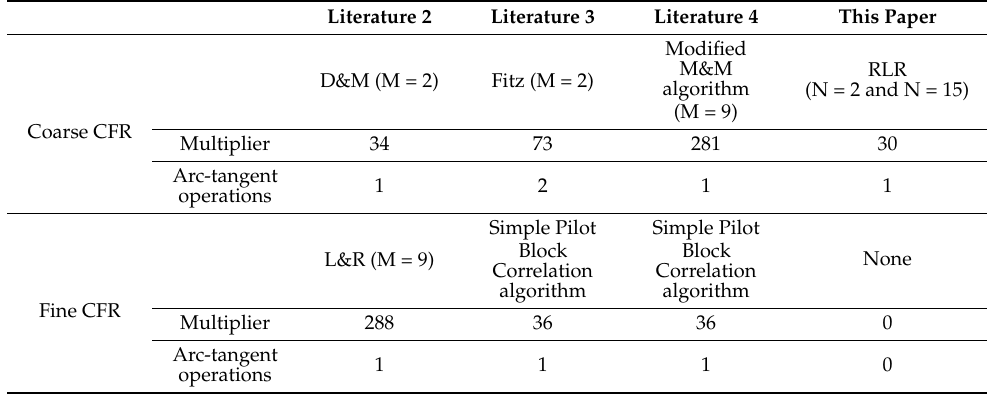
Table 1. Hardware complexity comparison.